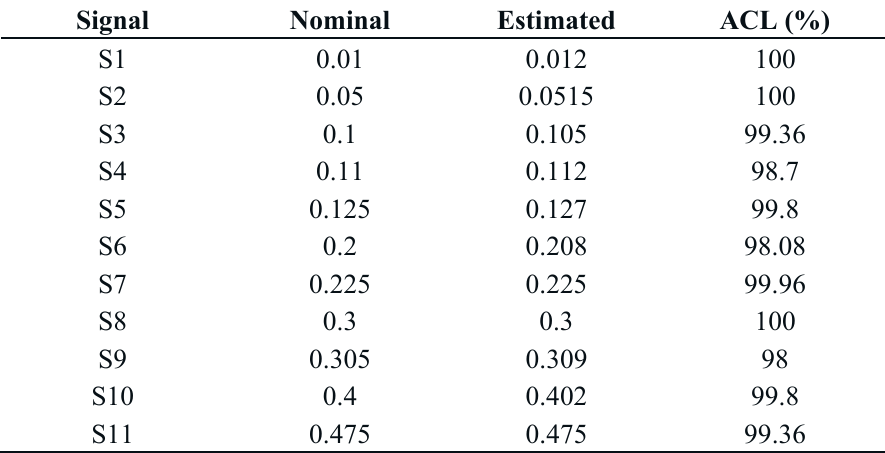
Table 1. Nominal frequencies of the signal, as well as frequencies of the power spectrum estimated by maximum entropy and its achieved confidence level